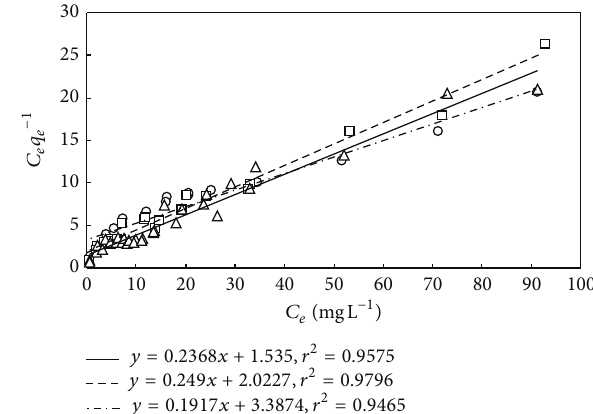
Figure 8: Adsorption of DMP on M-PVAL employing Langmuir isotherm. Cases with pH 0 = 5, 6.04–6.64, and 7 are expressed as ◻ (--): 𝑦 = 0.249𝑥 + 2.20227 , I (- ⋅ -): 𝑦 = 0.1917𝑥 + 3.3874 , and △ (—): 𝑦 = 0.2368𝑥 + 1.535 .